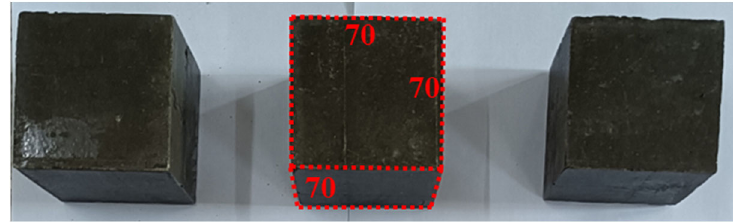
Figure 13. Polyurethane cement compressive test pieces at a 1:1 ratio (mm).